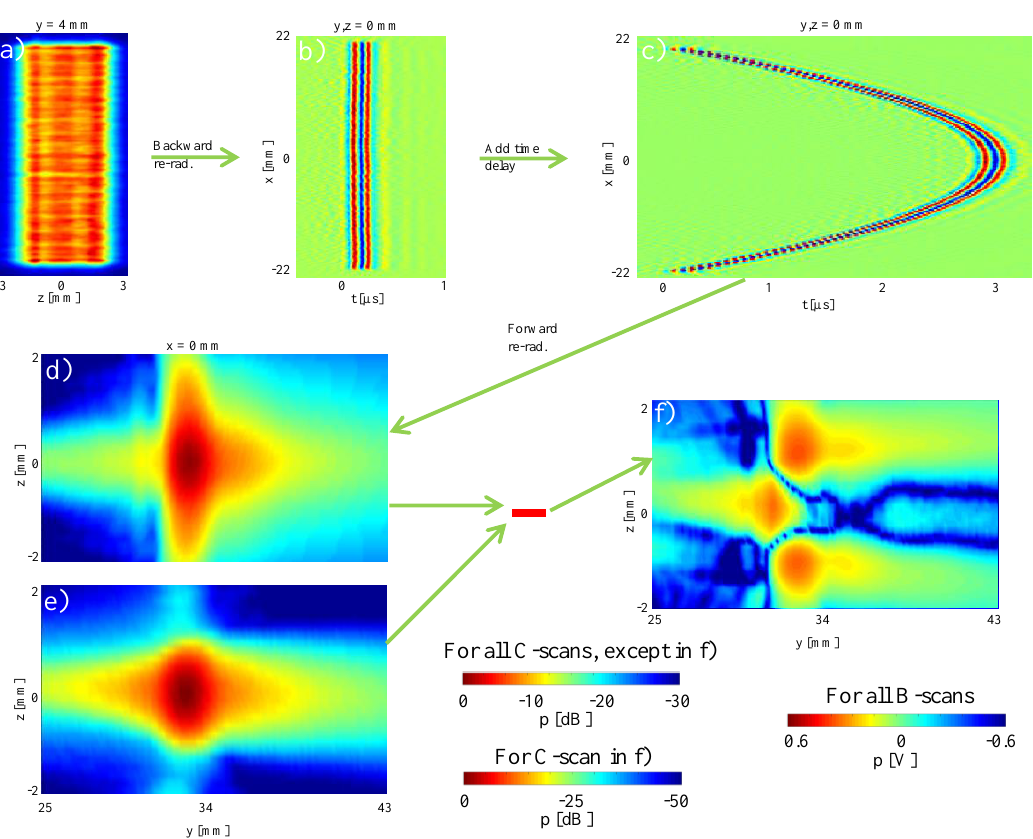
Figure 8. Simulated focusing: ( a ) measured pressure distribution 4 mm in front of the transducer; ( b ) B-scan result of the backward re-radiation to the transducer surface plane; ( c ) B-scan with an added time delay for a focus length of 30 mm; ( d ) simulated, focused sound field based on the forward re-radiation method; ( e ) measured sound field around the focal spot; ( f ) difference between the simulated and measured sound